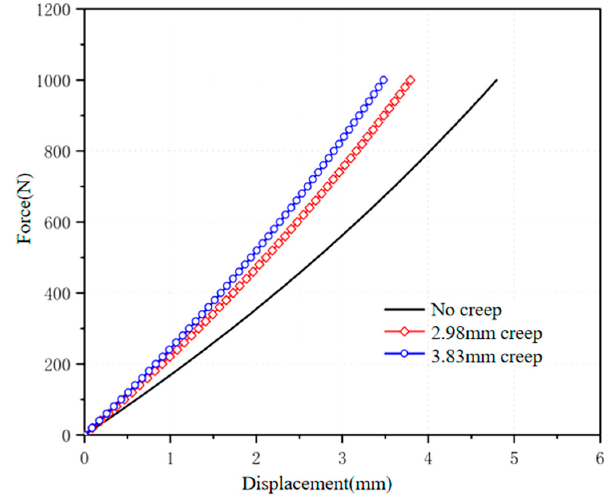
Figure 7. Static stiffness curve after suspension